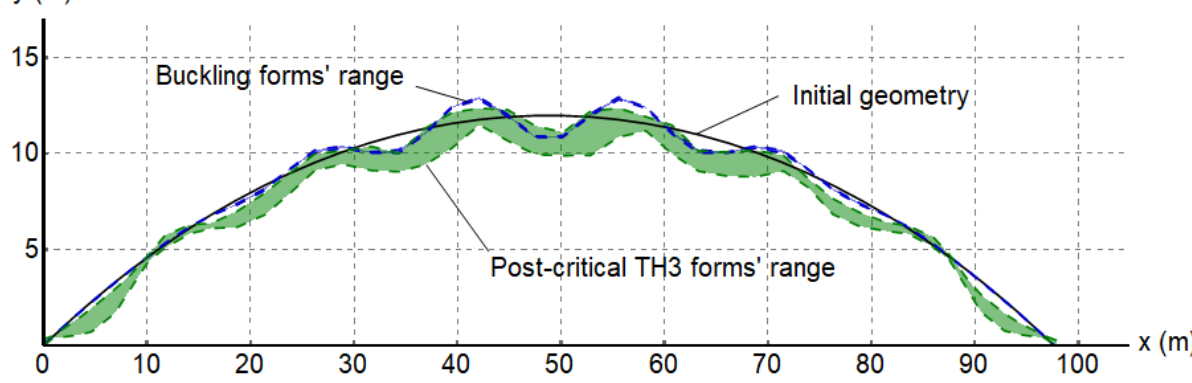
Figure 18: Scaled deformation forms of the arch between skewbacks from LBA and TH3